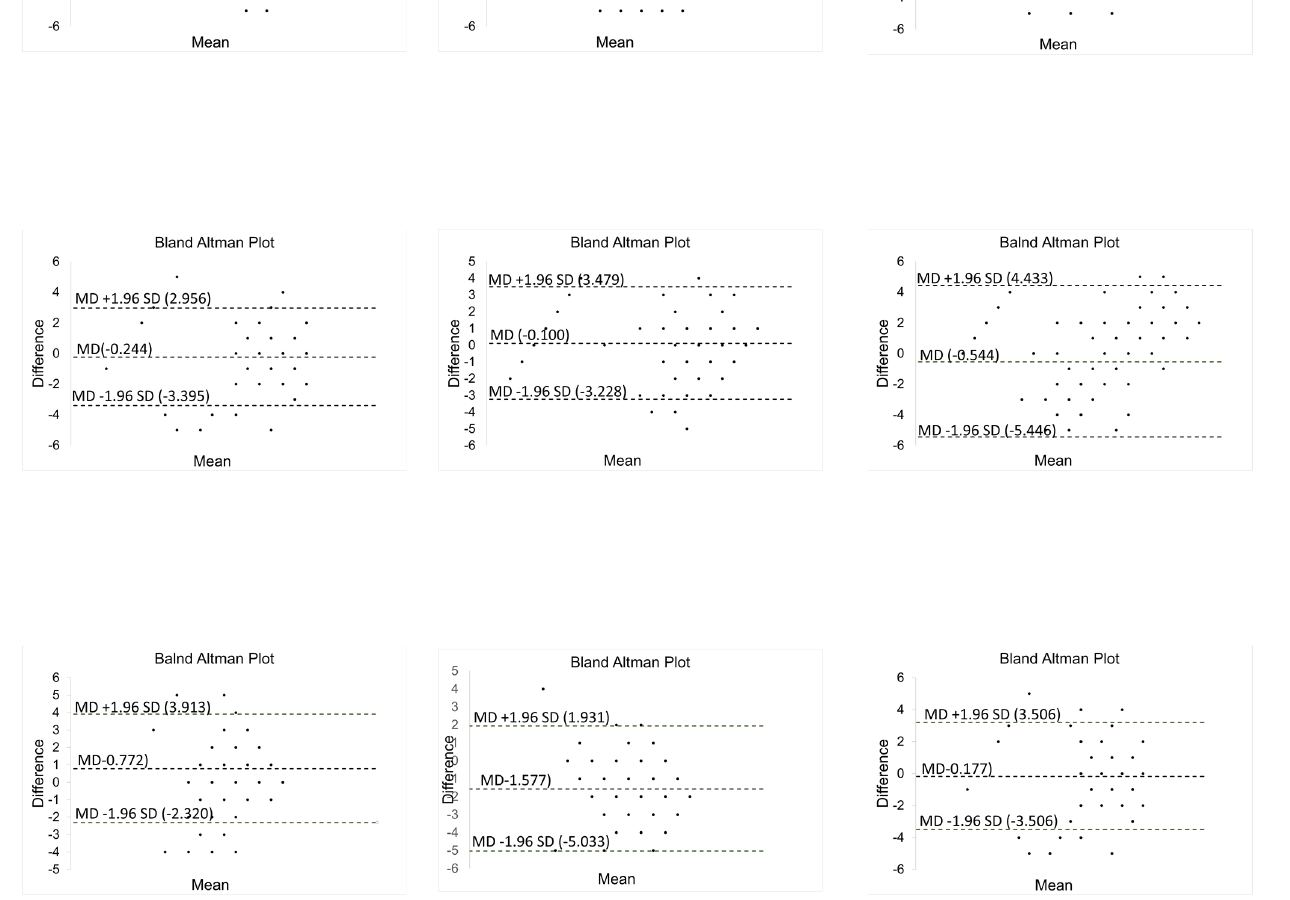
Figure 9. Bland Altman Plot for SBDA with PSG data for all 15 subjects.